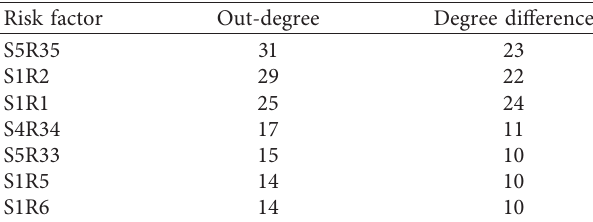
Figure 4: Stakeholder-associated PPP risk in the case project. macrolevel, ○ mesolevel, ∆ microlevel. local government, financial Table 3: Partitions of the risk factors in the case project. Block